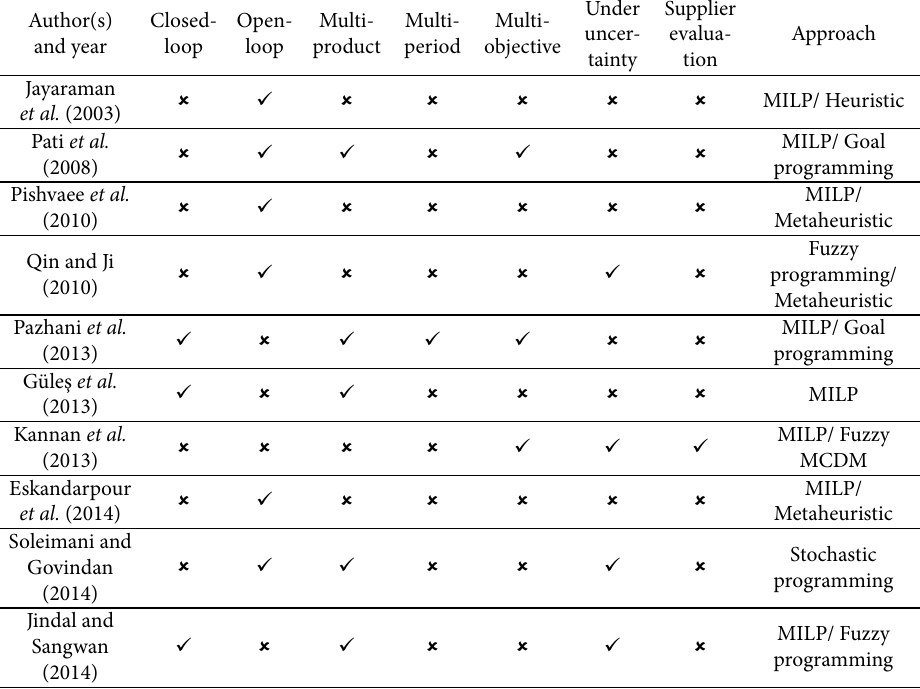
Table 1. Studies on supply chain network design with reverse